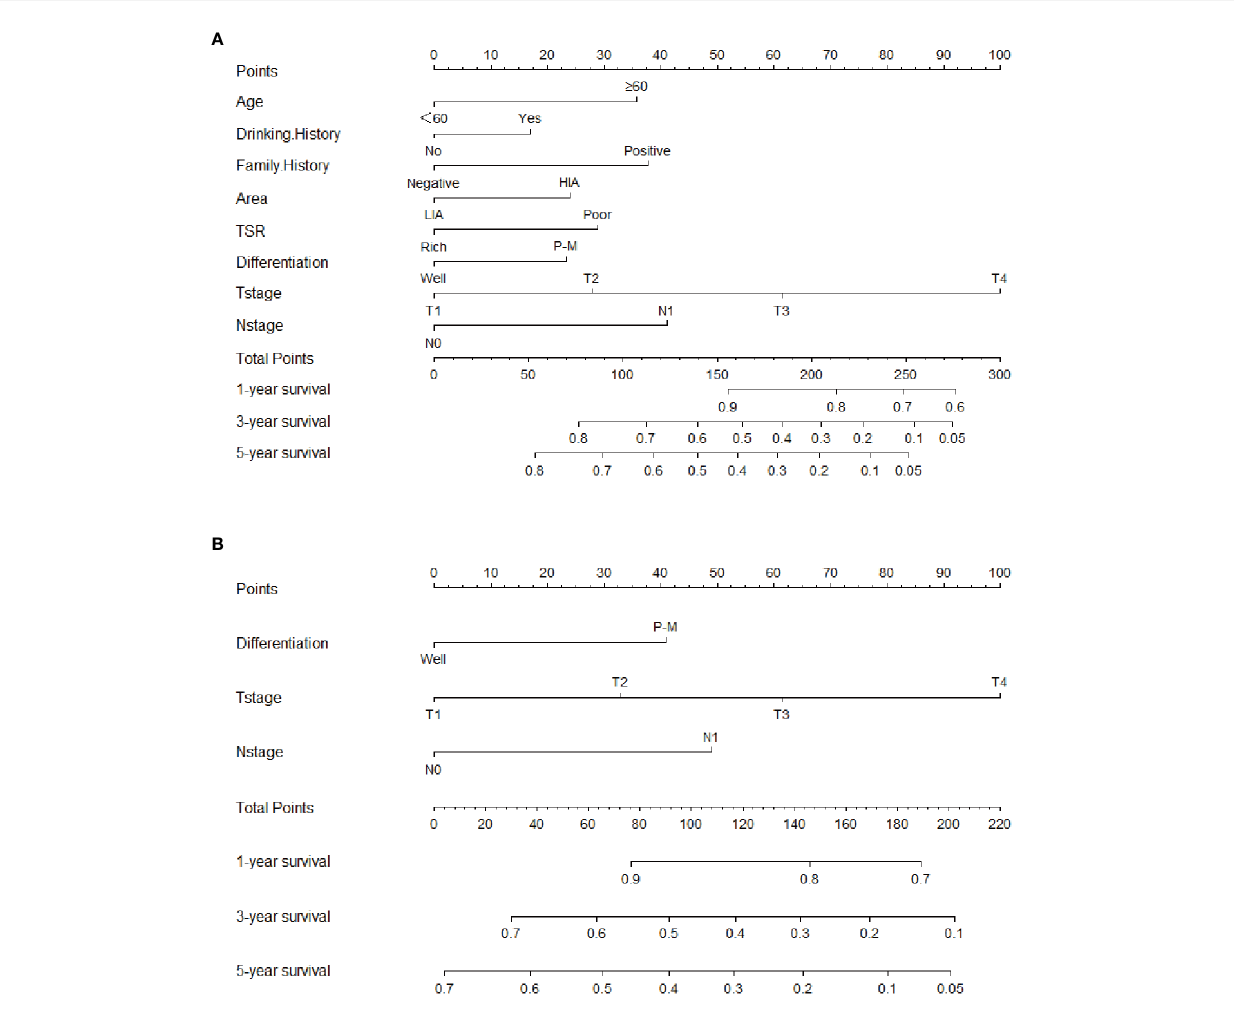
FIGURE 3 Clinical-pathological nomogram and TNM stage nomogram for 1-, 3-, and 5-year overall survival predicting in patients with esophageal squamous cell carcinoma. (A) Clinical-pathological nomogram. (B) TNM stage nomogram. HIA, High incidence area; LIA, Low incidence area; P-M, Poor or moderate